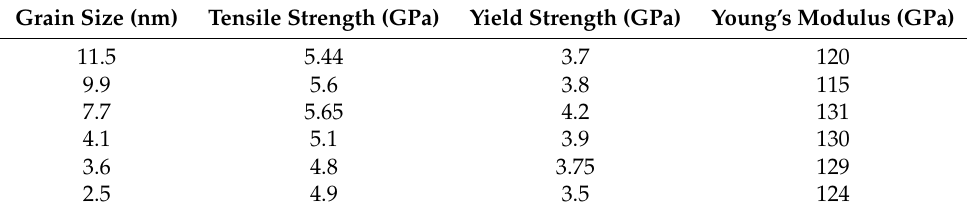
Figure 2. Simulated stress–strain curves for the nanocrystalline austenitic stainless steel samples with different grain sizes. di ff erent grain sizes. Mechanical properties of the nanocrystalline austenitic stainless steel samples at room